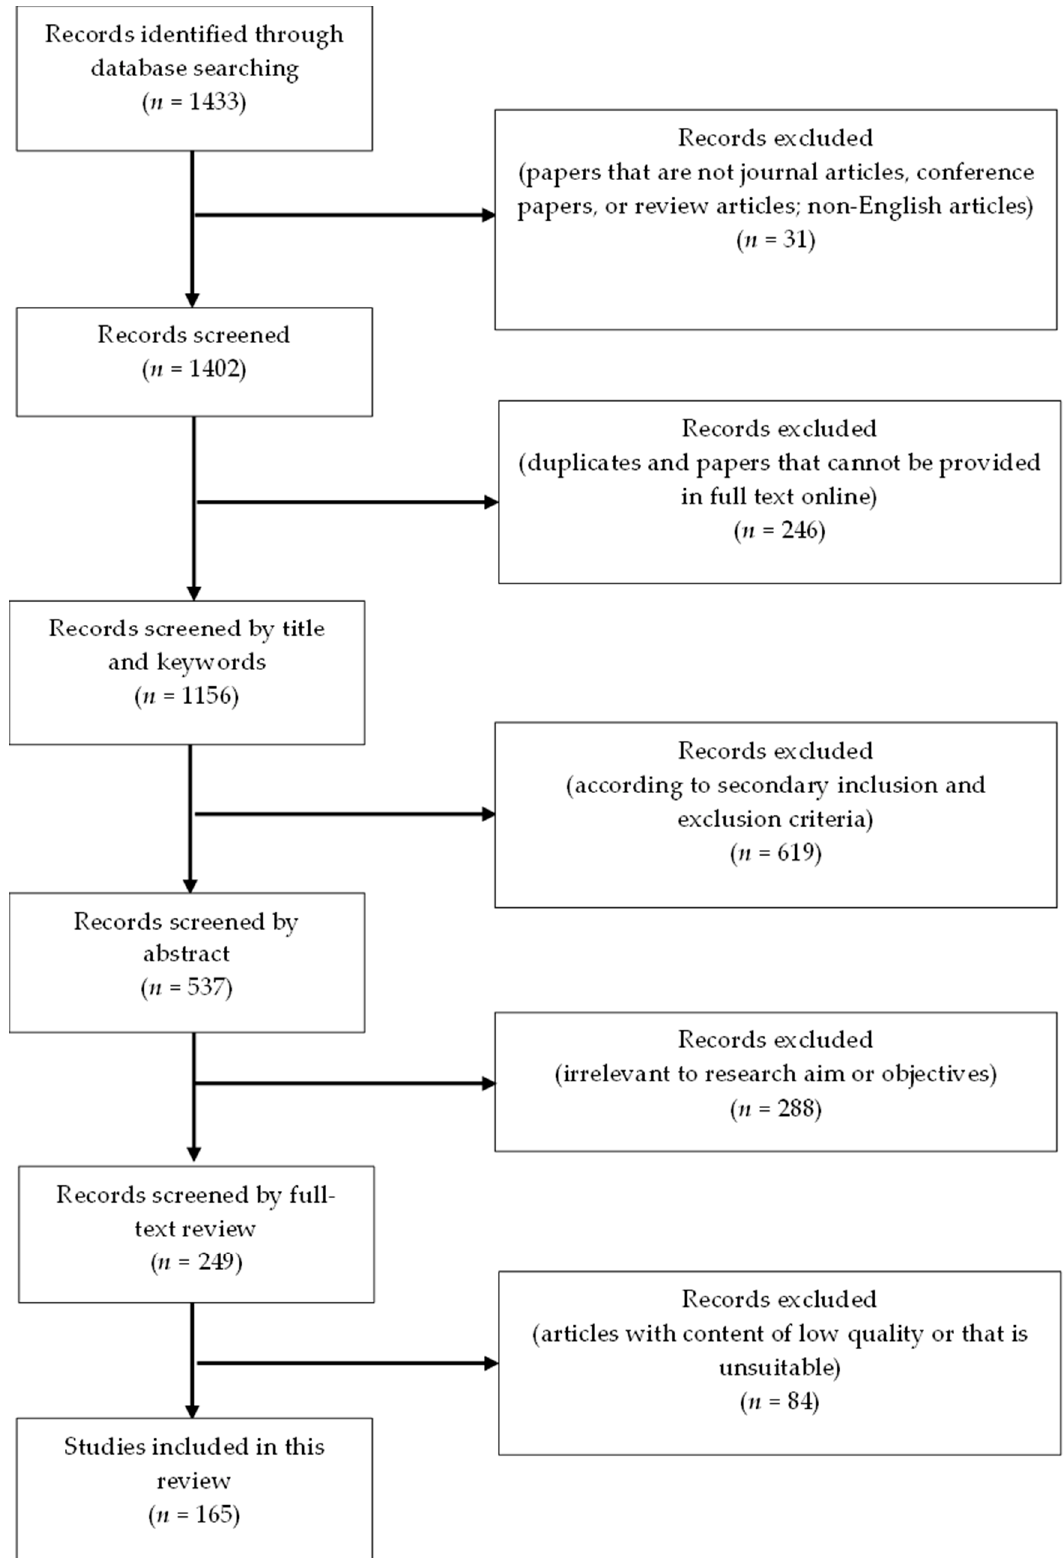
Figure 1. Flowchart of article screening process used in this study. Through the full-text review of the included studies, the BIM capabilities can be cat- egorized according to their contribution areas (see in Table 3).